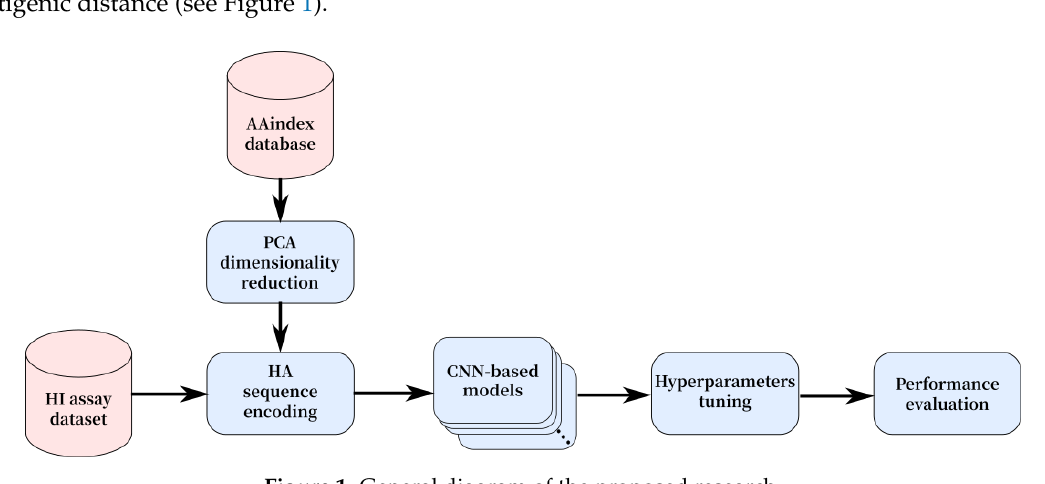
Figure 1. General diagram of the proposed